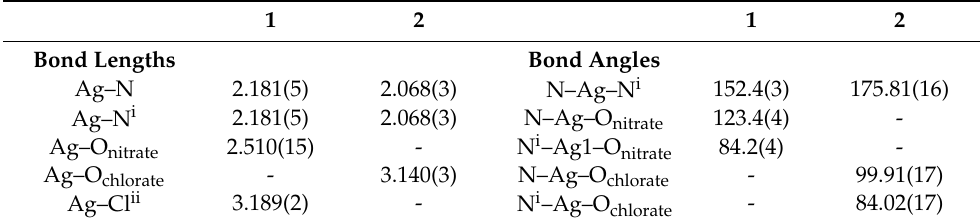
Table 3. Geometry (Å, ◦ ) around silver(I) in complexes 1 and 2